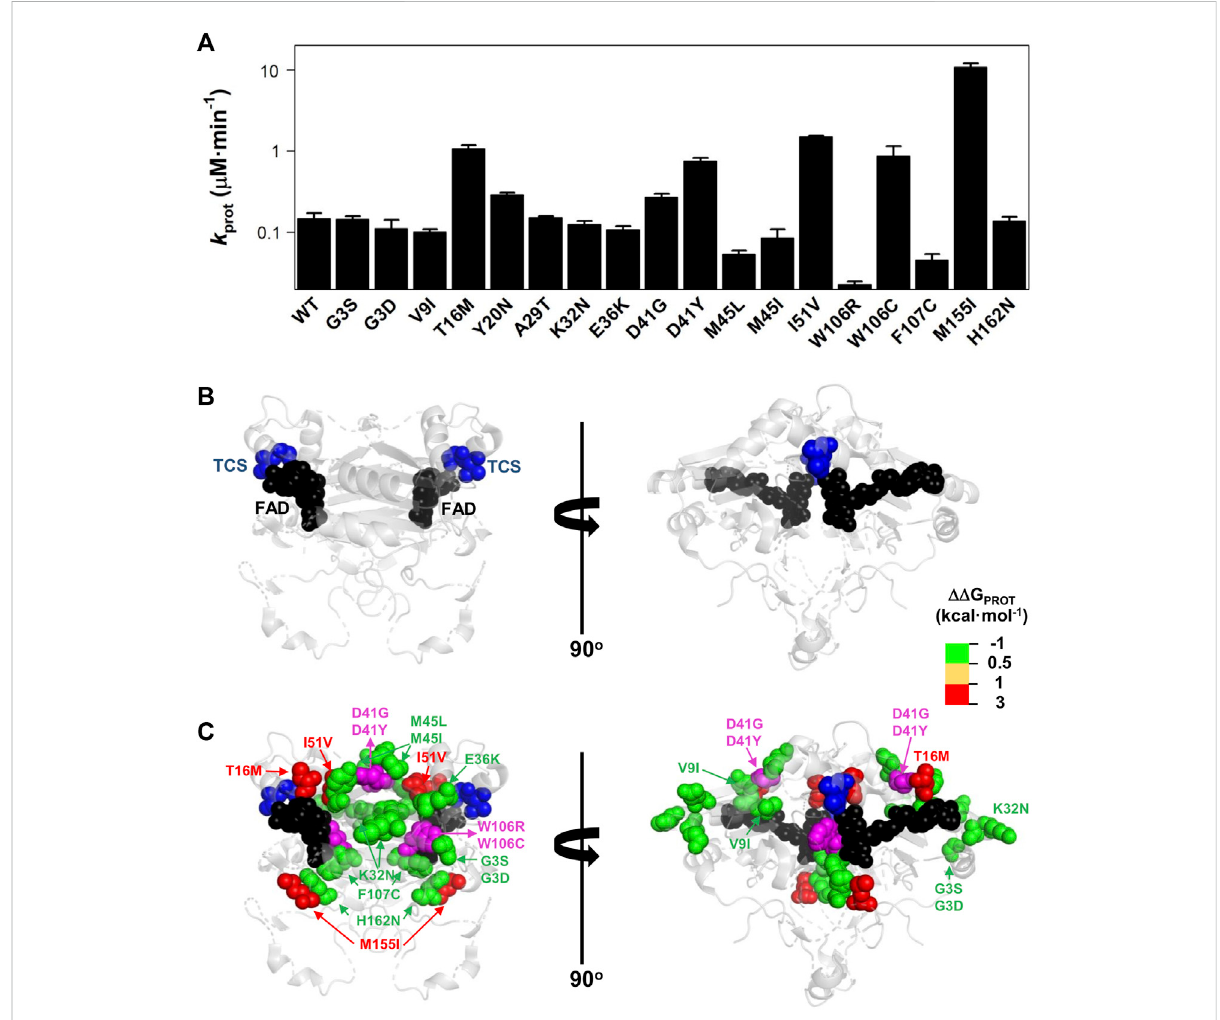
FIGURE 7 Variant effects on the local stability of the FBS from proteolysis. (A) Second-order rate constants for proteolysis of NQO1 variants (Supplementary Figure S5C). Errors are those fi ttings. These k PROT values were used to calculate the TCS local energy free difference ( ΔΔ G PROT ) betweenagivenvariantandtheWTprotein(notethatapositivevalueindicatesloweraf fi nity). (B,C) StructurallocationoftheFAD(blackspheres)and the TCS (blue spheres) (B) . In (C) , mutated residues (colour scale according to their destabilizing effect on FAD binding) (C) are overlayed with TCS and FAD. The residues D41 and W106 are highlighted in magenta due to the widely different effects of the D41G/D41Y and W106R/W106C substitutions. Note that two views rotated 90 ° are shown. The structural model used for display was PDB code 2F1O (Asher et al.,